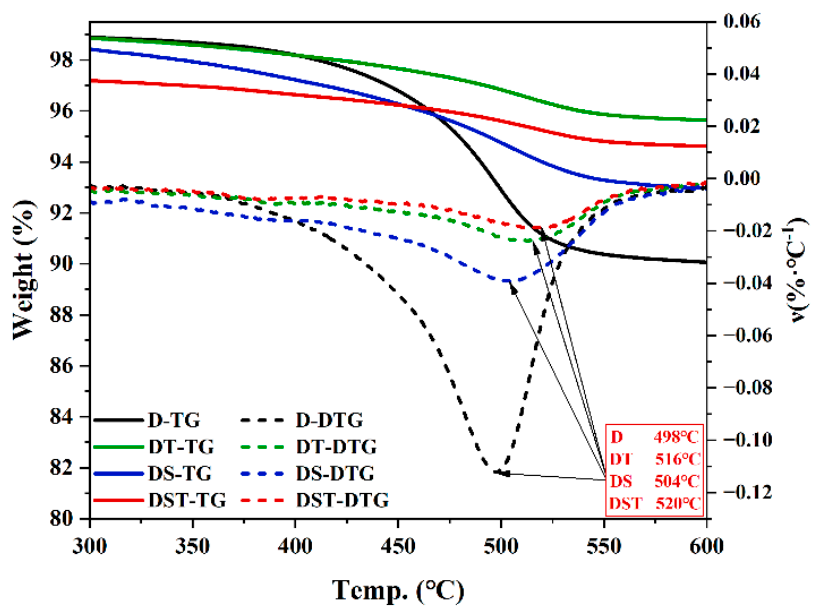
Figure 8. TG curves (solid lines) and DTG curves (dotted lines). Arrows point to maximum rates of weight loss. Values of temperature at the maximum rates of weight loss are provided in the lower right corner.